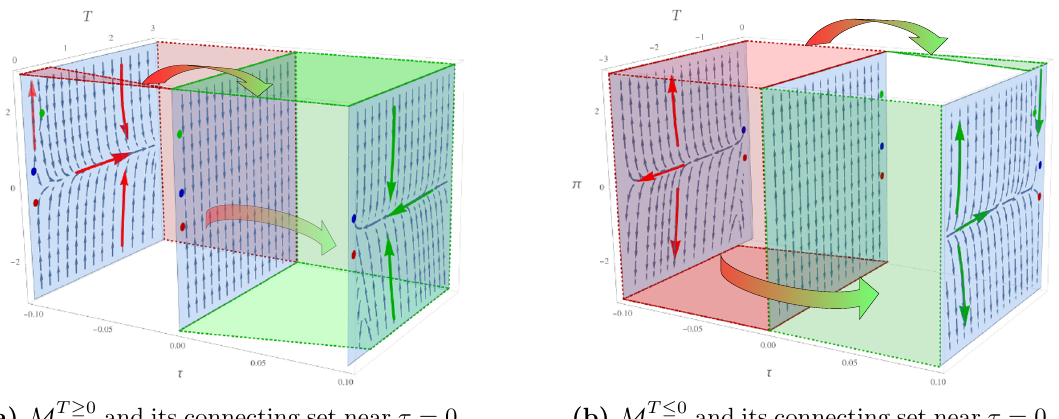
Figure 3. Connecting sets of the (cid:12)ber structures around (cid:28) = 0. Typical (cid:12)ber structure M (cid:6) (cid:14) is shown in blue at (cid:28) = f(cid:0) 0 : 1 ; 0 ; 0 : 1 g for the past and future domain, where the colored circles show the evolution of (cid:12)xed point (cid:6) A (blue), (cid:6) B (red), and (cid:6) C (green) on these (cid:12)bers. The connecting set of each separate space M T ? 0 is portrayed in red for N (cid:0) and in green for N + where arrows indicate the directions of (cid:13)ow lines. The nontrivial poset for M T (cid:21) 0 is determined as follows: We (cid:6) (cid:14)